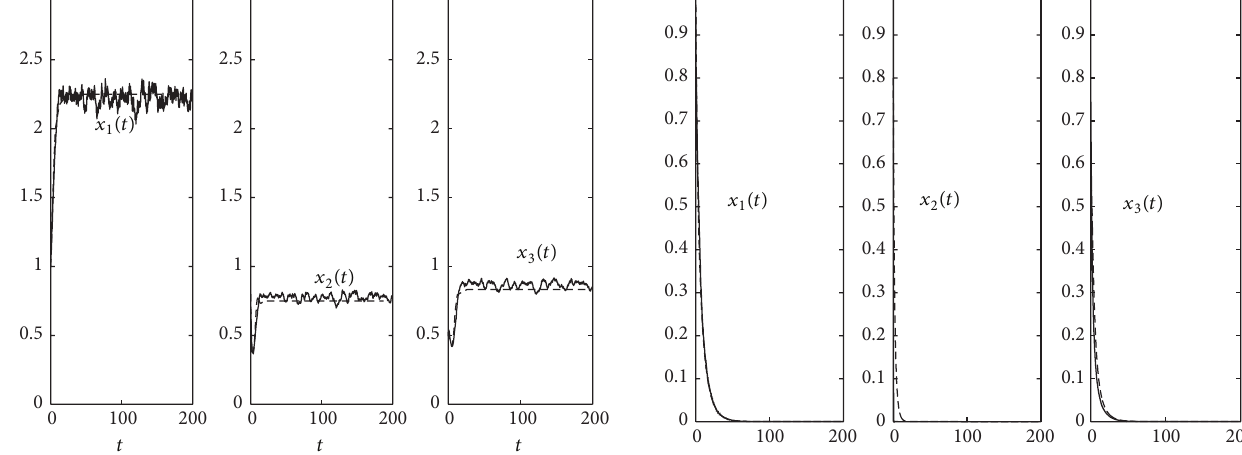
Figure 3: One of the species or both species will die out in probability. The red lines represent the solution of system (1), while the blue lines represent the solution of system (3) with (0),𝑥 (0),𝑥 (0)) = (1, 0.8, 0.5) , 𝑎 = −0.1 , 𝑎 = 0.4 , 𝑎 = 0.1 , (𝑥 1 2 3 1 2 3 = 0.1 , 𝑏 = 0.1 , 𝑏 = 0.6 , 𝑏 = 0.6 , 𝑏 = 0.6 , 𝑏 = 0.8 , and 𝑏 11 12 21 22 23 32 = 0.6 . The red lines represent the solution of system (1), while 𝑏 33 the blue lines represent the solution of system (3) with 𝜎 1 = 0.02 , = 3 , and 𝜎 = 0.01 𝜎 2 3